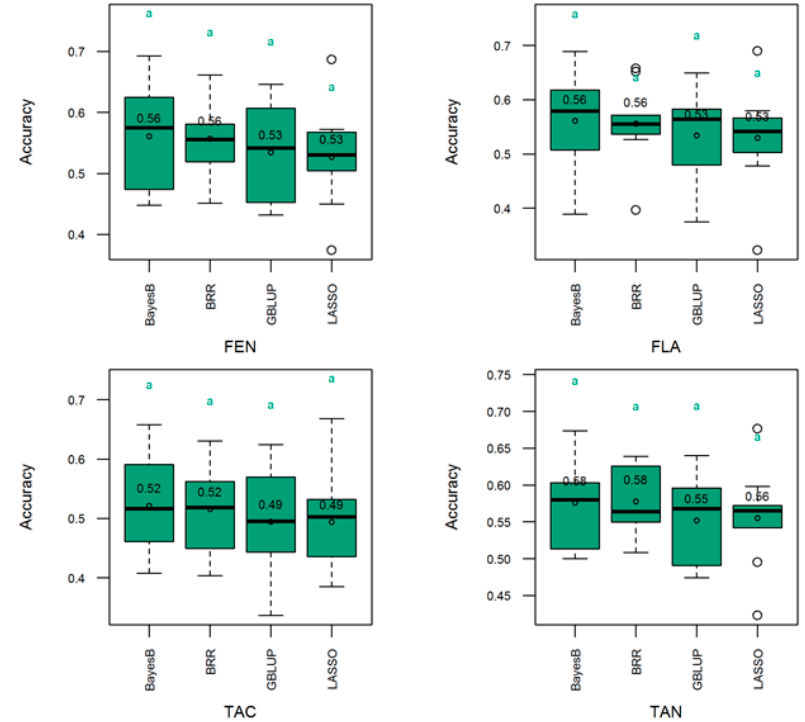
Figure 6. Distribution (boxplot) of GS models validated accuracy in external sample (not used during model training) of 34 (30% of the total population) sorghum lines. FEN, FLA, TAC, TAN, respectively, polyphenols, flavonoids, total antioxidant capacity, and condensed tannins. Traits means are included within the boxplot. Trait means with same letter are not significantly di ff erent at the 5% level using